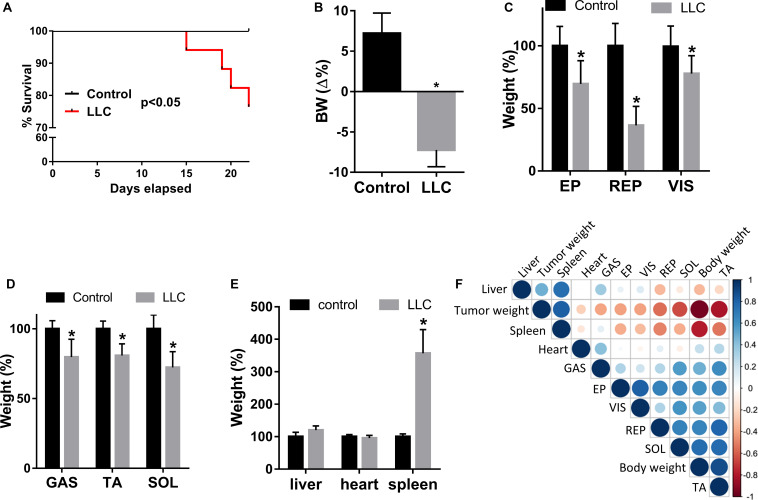
Lewis Lung Cancer (LLC) cells induce cachexia in mice. (A) Kaplan-Meier survival curves of control and tumor-bearing mice (LLC) groups. (B) Body weight (BW = Δ%), defined as total BW - tumor weight, and reported as a percentage of the initial BW. (C) Epidydimal (EP), retroperitoneal (RP), and visceral (VIS) fat weight loss in LLC respective to control. (D) Gastrocnemius (GAS), tibialis anterior (TA), and soleus (SOL) muscle weight loss in LLC respective to control. (E) Liver, heart, and spleen weight in LLC respective to control. (F) Triangular heatmap representing pairwise Pearson correlation of the different morpho-anatomical data; blue and red dots represent positive and negative correlations, respectively. Data are expressed as mean ± SD; control (n = 10) and LLC (n = 20). *p < 0.05: statistical significance compared to the control group (two-tailed t-test).